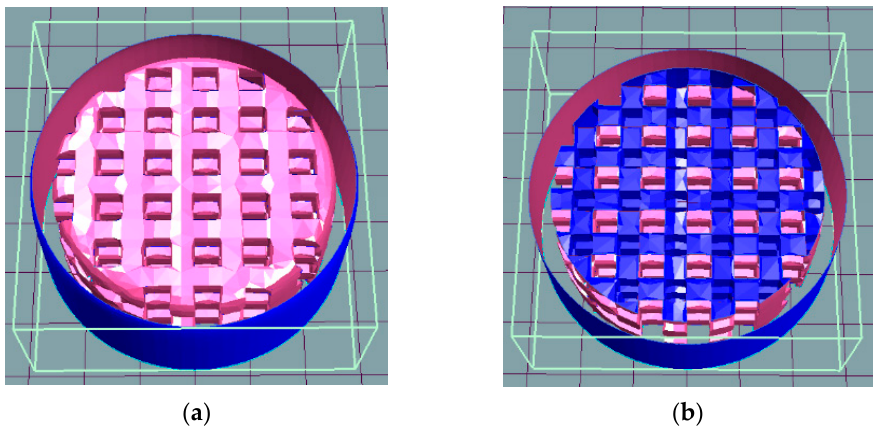
Figure 4. X-sectional views of test specimen with ( a ) complete lattice structure within the shell ( b ) internal structure of the hollow